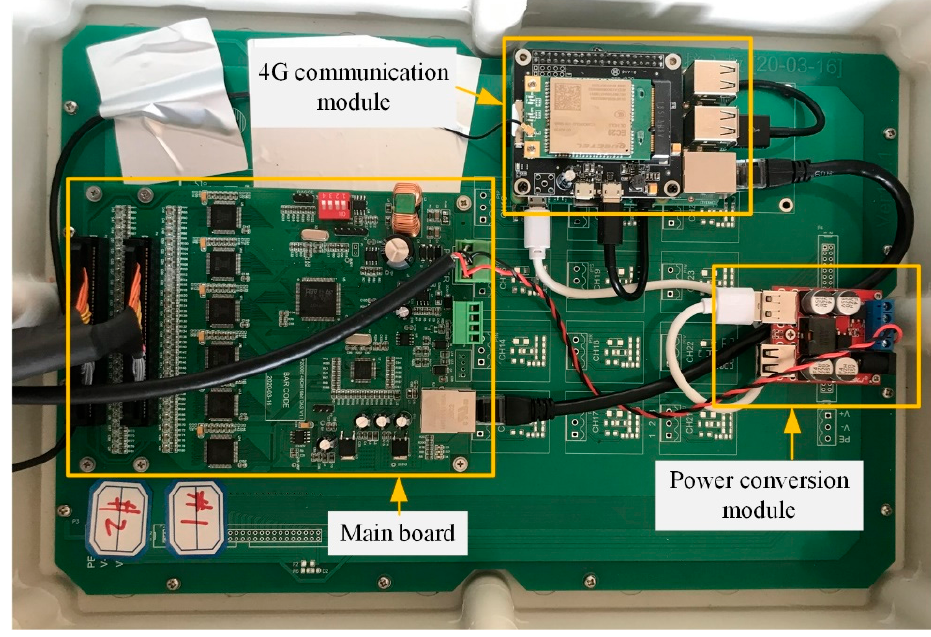
Figure 8. Gateway composition.